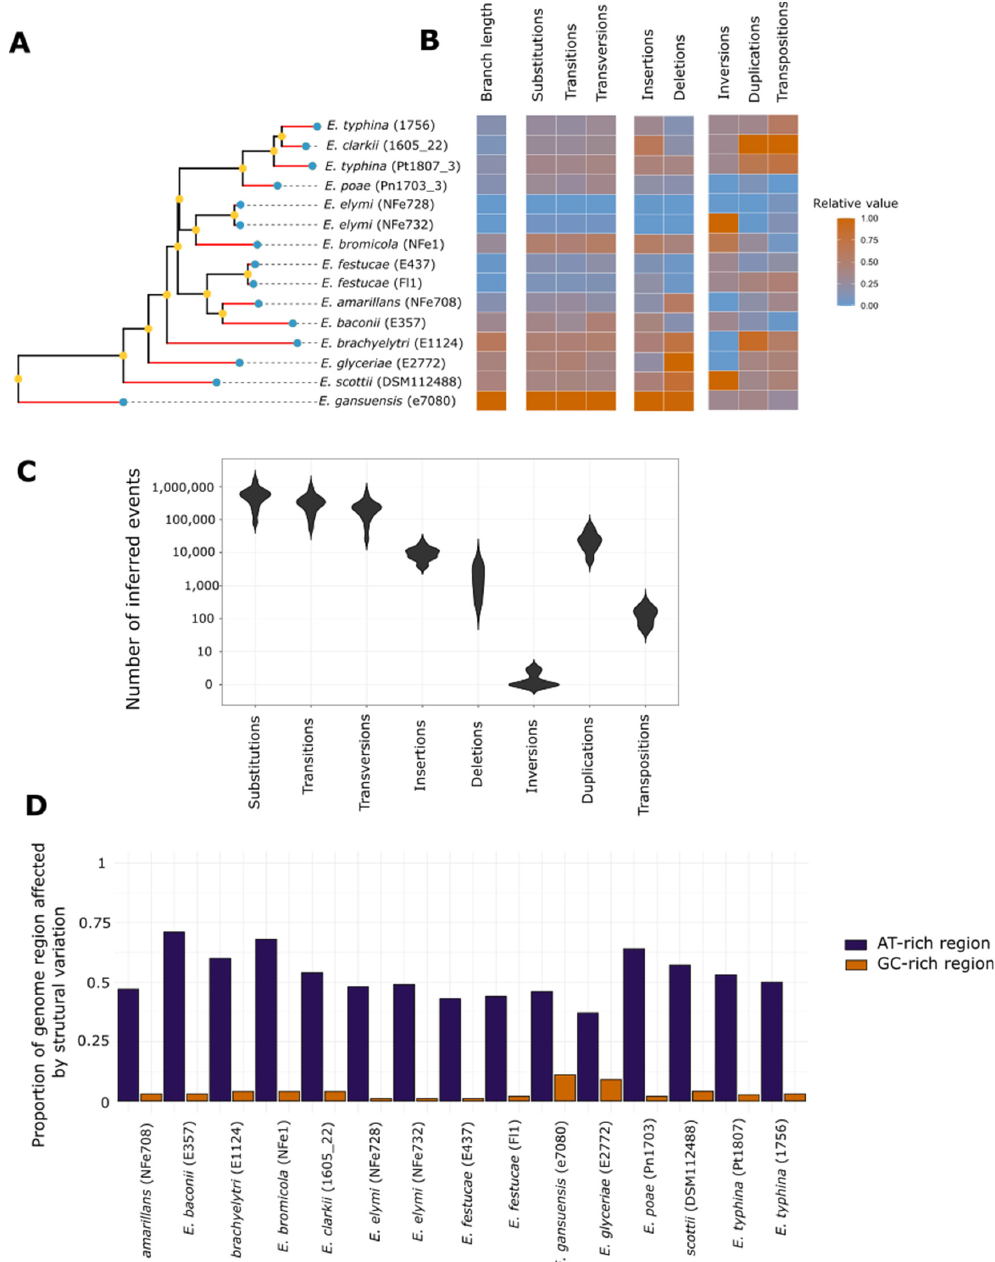
Figure 2. ( A ) Phylogenetic relationships between the 15 Epichloë species/strains inferred using maximum likelihood from 1,489 single copy gene orthologs. Blue dots indicate the positions of extant genomes; yellow dots indicate inferred ancestral genomes; mutations inferred by Progressive Cactus were counted on the red branches. All branches have support values of 1. ( B ) Heatmap highlighting the relative numbers of eight mutation classes accumulated on the terminal branches of the phylogeny between the closest ancestral genome and extant taxa. All rates are scaled from zero to one, with zero corresponding to the lowest number of mutations in the dataset and one to the highest. ( C ) Violin plots showing the absolute numbers of the eight mutation classes accumulated on terminal branches, with a log-scaled y axis. ( D ) Proportion of gene and repeat regions impacted by structural variation in each Epichloë strain, relative to the ancestral genomes inferred using Progressive Cactus. For each genome, the proportion of affected nucleotides was calculated by looking at the coverage of sequences duplicated, inverted, transposed and inserted relative to the closest ancestral genome.